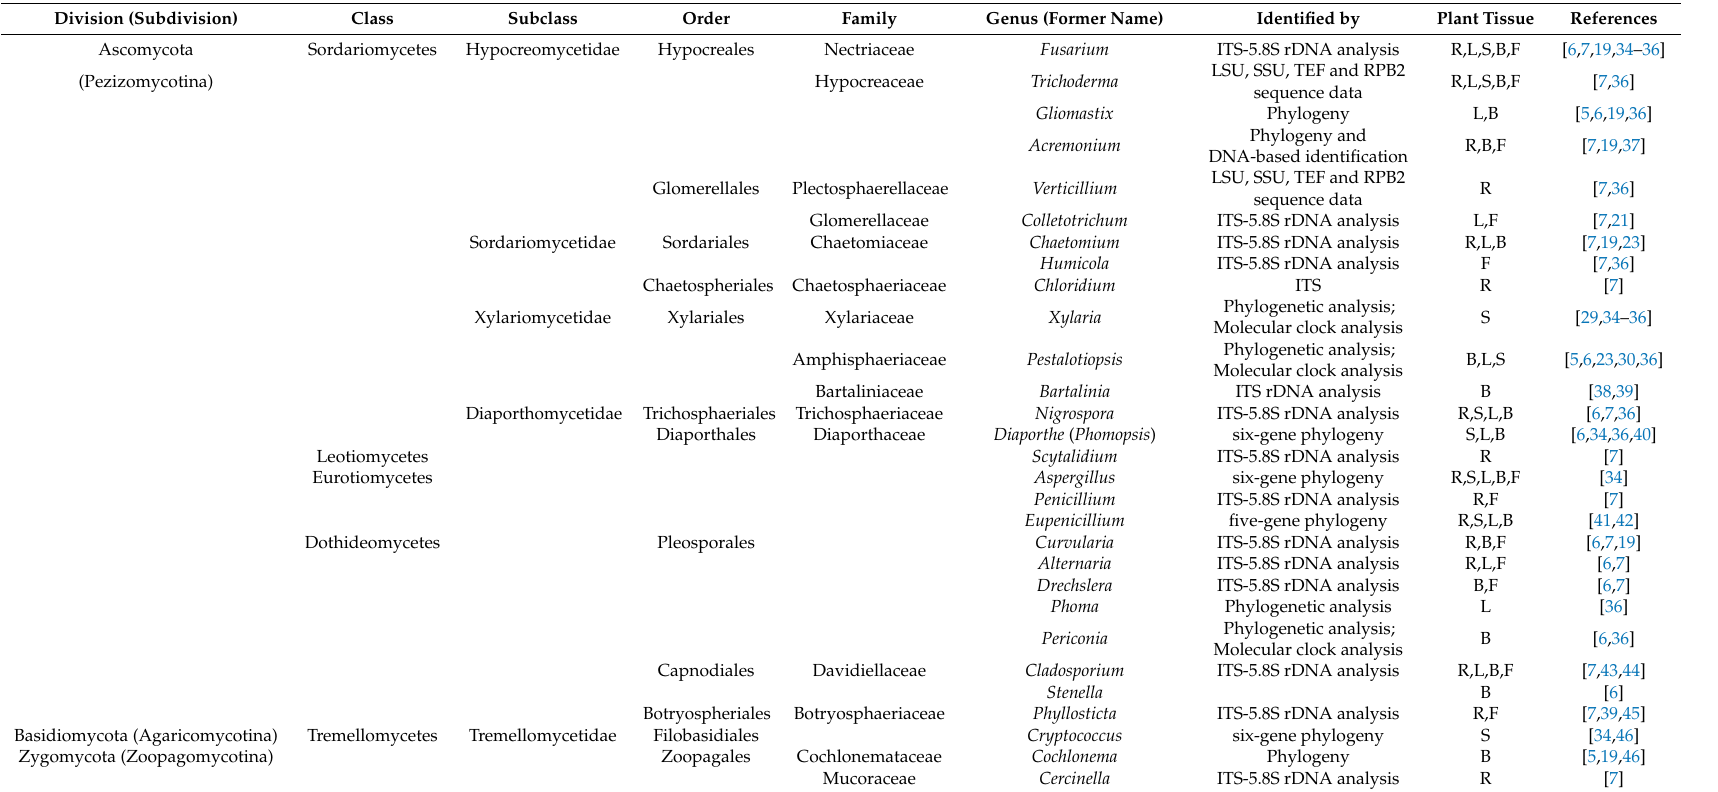
Table 1. Endophytic fungi from different parts of neem